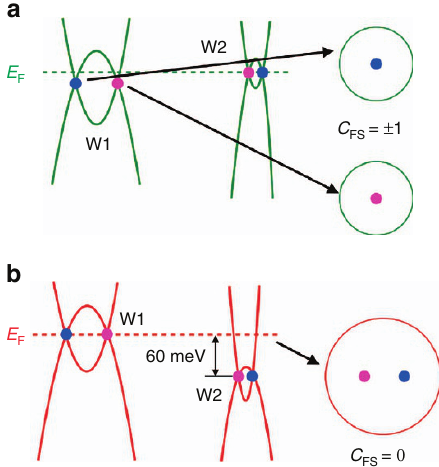
Figure 5 | Band structures near Weyl nodes in TaAs and TaP. ( a ) The illustration of energy dispersions along cut x for W1 and W2 in TaAs. The Fermi surface encloses a single chiral Weyl node and the C FS is ± 1. ( b ) Same as a but for TaP. The Fermi surface encloses two W2 Weyl nodes with opposite chirality and the C FS is